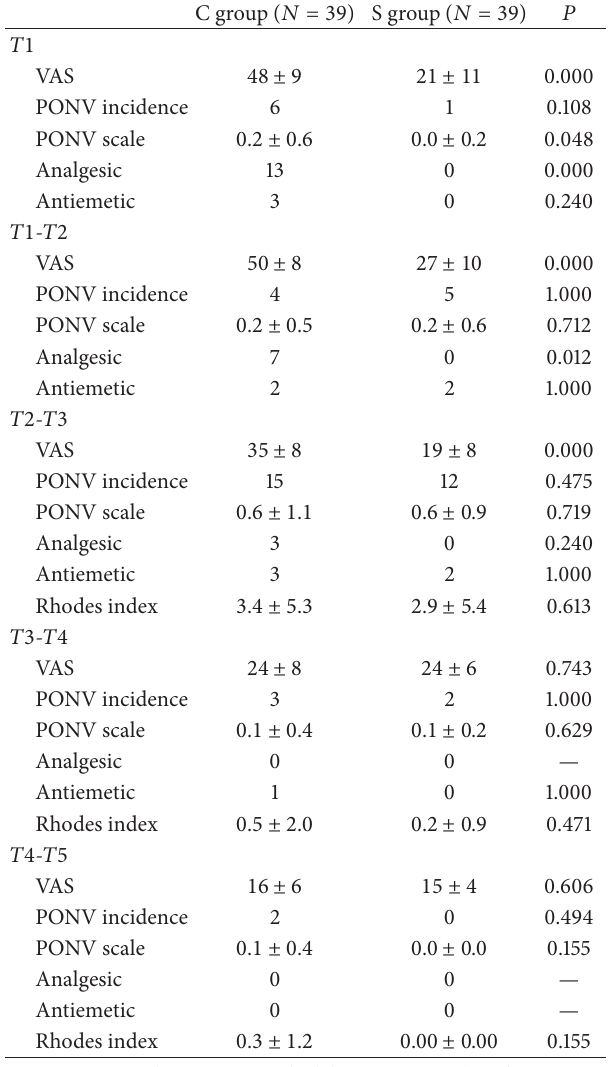
Table 3: Postoperative pain based on visual analogue scale (VAS) and postoperative nausea and vomiting